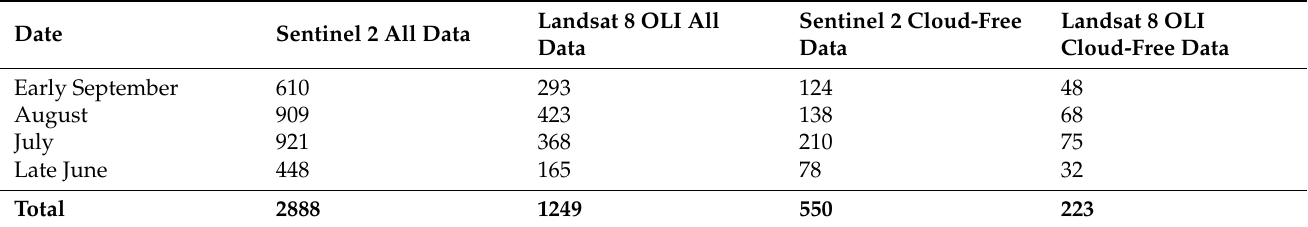
Table 2. Landsat 8 OlI and Sentinel 2 dataset of the study region in